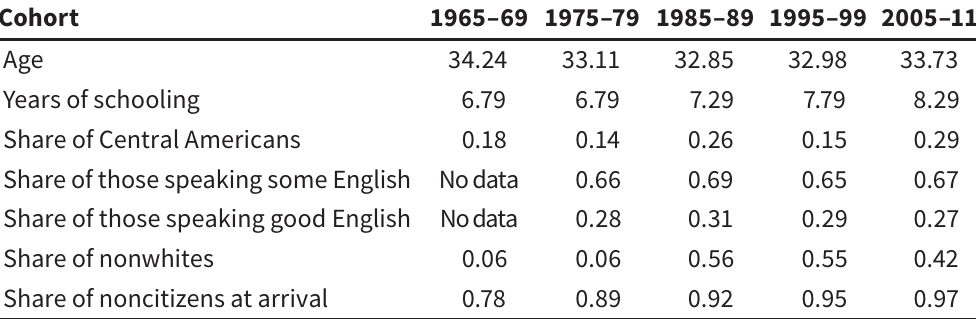
Summary statistics for Mexican and Central American immigrant cohorts upon